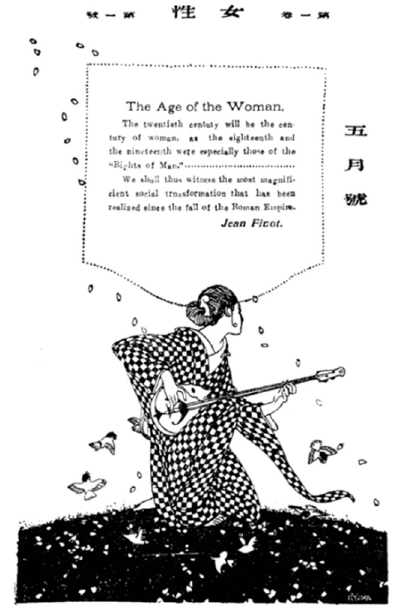
Figure 1. The introductory page to the inaugural issue of Josei magazine is entitled “The Age of the Woman”, and all that is printed is the words of French sociologist Jean Finot. Scholar Koyama Shizuko points out that though Josei was filled with opinion articles, very few of them concerned labor issues, the abolition of licensed prostitution, or women’s movements, and argues that in contrast to Fujin k ō ron, the magazine was restricted by class and there was little interest in social movements (Koyama 1993). While at the beginning of its publication, there were many opinion articles that discussed general women’s issues, after the Great Kanto Earthquake in 1923, the number of opinion articles fell, and the publication of literary works increased. Of the opinion articles that remained, Koyama points out that the articles themselves dealt primarily with how women should live their lives and consequently what kind of changes in customs and habits were occurring. Again, while Fujin k ō ron wrote about the problems of the working woman and on the necessity of having a job, in Josei , publications were limited to introducing this new type of woman, the professional working woman. Koyama concludes that Josei magazine “was the type of glamorous magazine with an urban atmosphere that took on the role of a mirror, reflecting the appearance of new types of women” (Koyama 1993).